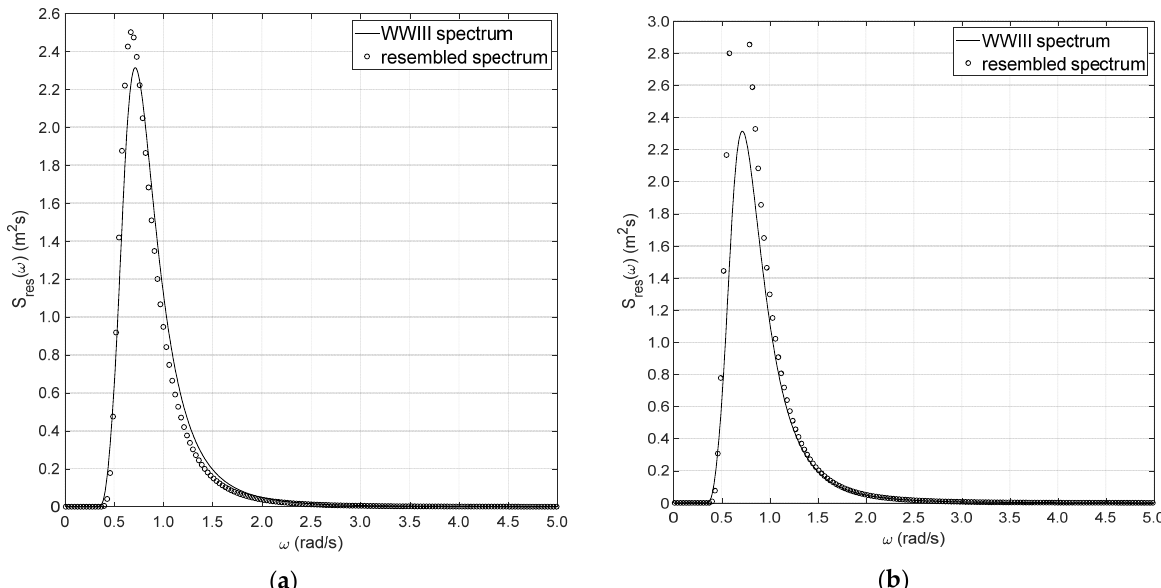
Figure 8. Sea spectrum—14 February 2020: ( a ) resembled combined sea spectrum using heave and pitch motions; ( b ) resembled combined sea spectrum using heave and pitch accelerations.